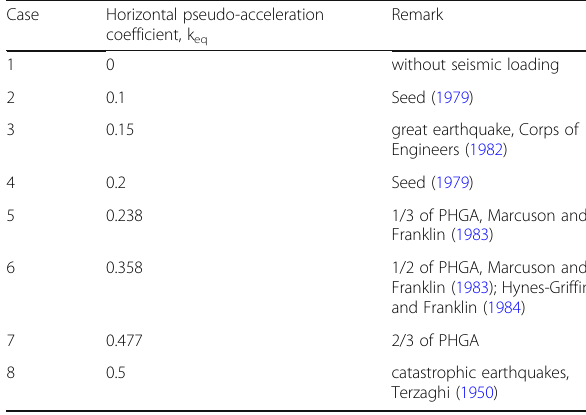
Table 4 Eight horizontal pseudo-acceleration coefficients applied in the calculation in eight